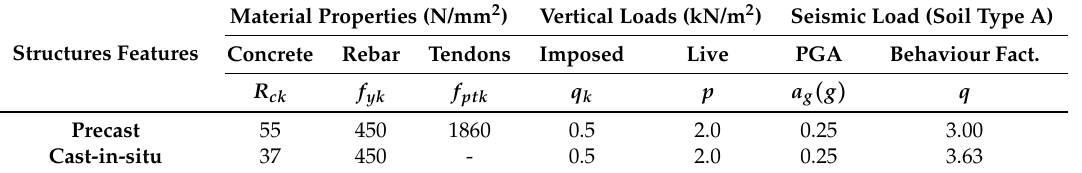
Table 2. Material properties and design loads on the structures.